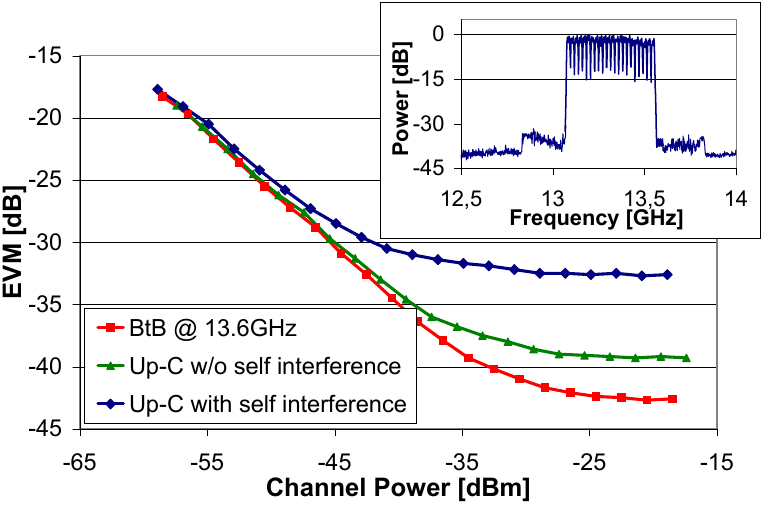
Figure 4. EVM for the channel with worst case self-interference, obtained with optical up-conversion and compared with an electric (BtB) one. The comparison with the EVM curve of a self-interference-free channel is also shown. Inset: 13.333 GHz channel spectrum.